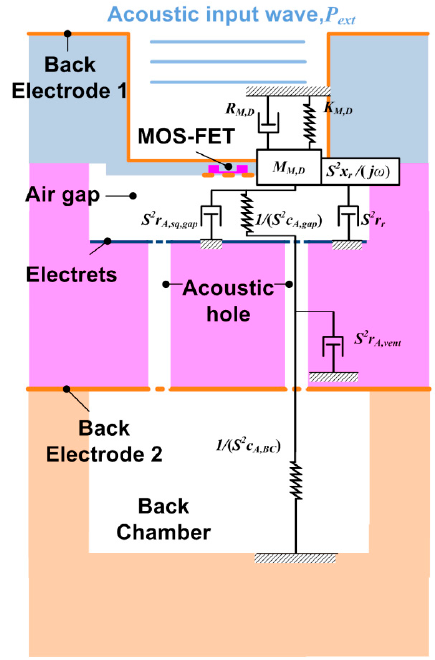
Figure 3. Lumped parameter model of the ElGoFET microphone. All of the mechanical and acoustical structures are expressed as lumped mass, spring, and damper components.